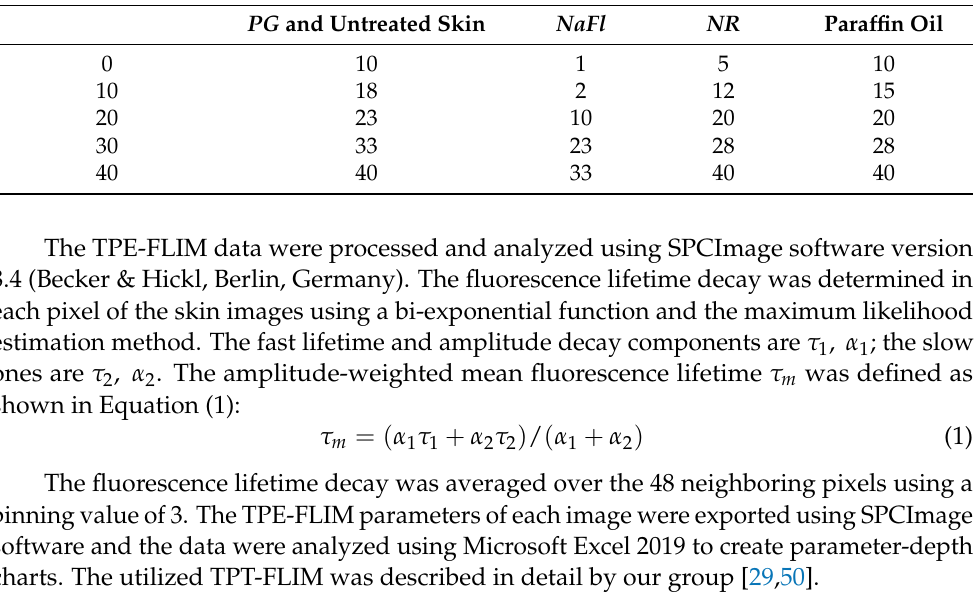
Table 1. Laser power (TPE at 760 nm) for the fluorophore-treated skin depending on the depth. Skin Depth [ µ m] Excitation Power [mW] PG and Untreated Skin NaFl NR Paraffin Oil